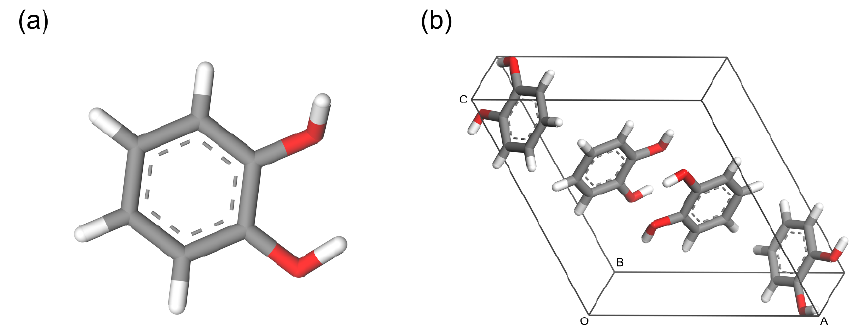
Figure 1. The molecular structure ( a ) and the unit cell ( b ) of catechol. Table 1. The comparison of the initial and the optimized lattice parameters of catechol. Lattice